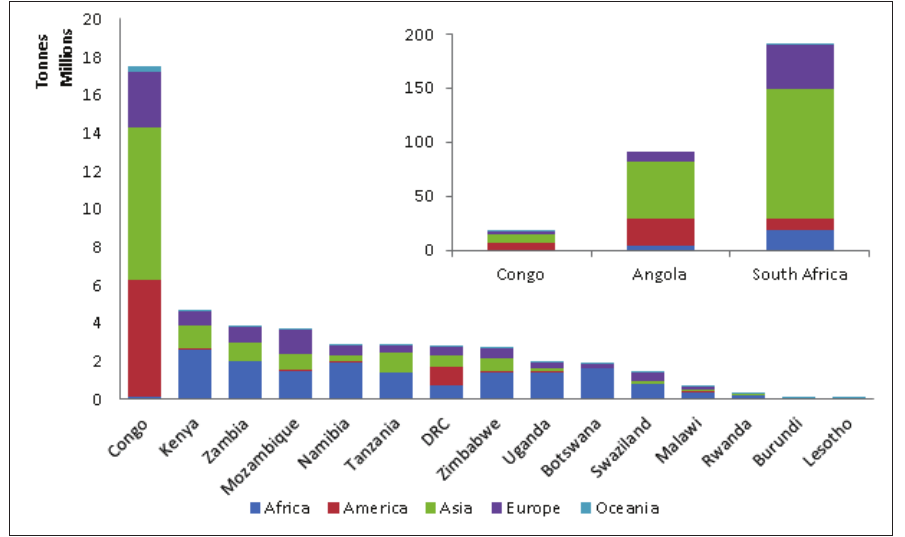
Figure 4: Export volumes to the five continental groups for 2010